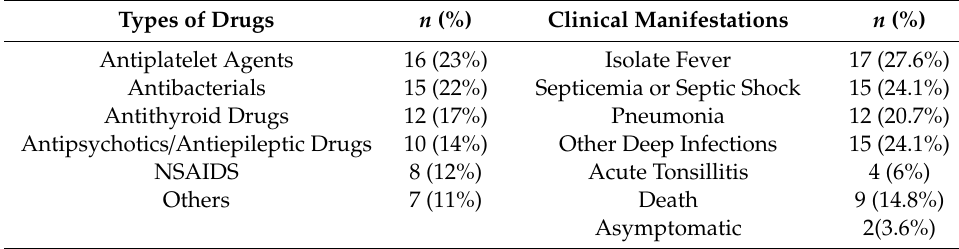
Table2. Typesofdrugsinvolvedandtheirclinicalmanifestationsinpatientsaged ≥ 75years, followed-up for idiosyncratic drug-induced agranulocytosis cohort study of the University Hospital of